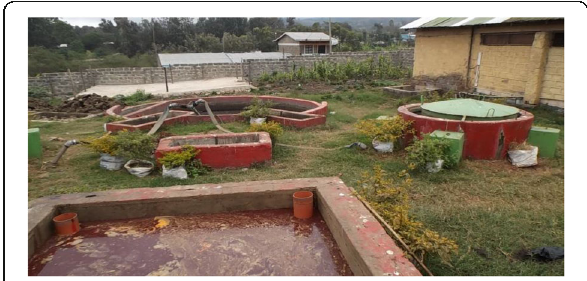
Fig. 6 Biogas generation system for managing liquid waste in